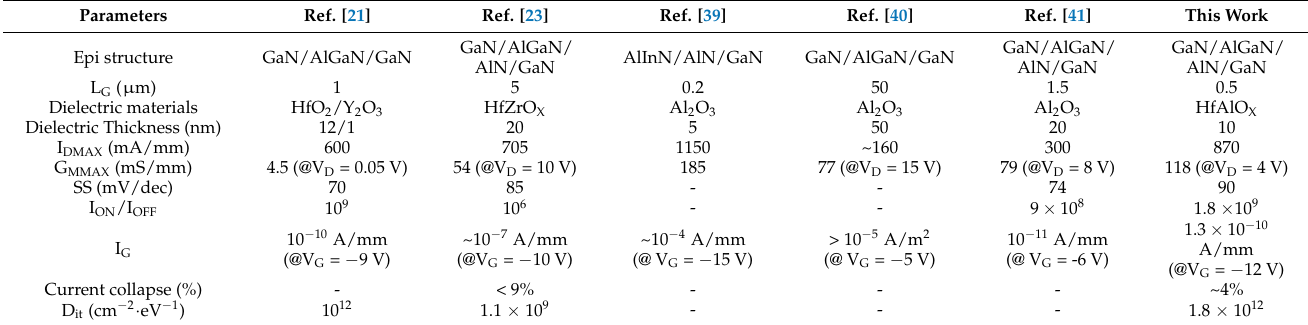
Table 2. Comparison of Electrical performances of Γ -gate HfAlO X -based MOS-HEMT with Al 2 O 3 and HfO 2 MOS-HEMT.